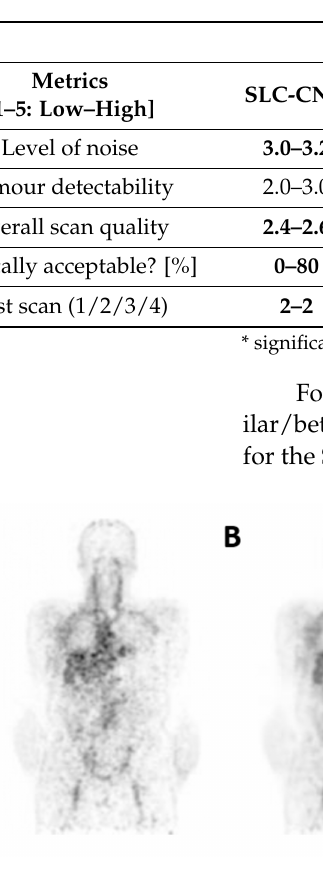
Figure 5. Illustration of a ( A ) FC, ( B ) SLC-CNN, ( C ) BF 3 mm, ( D ) BF 4 mm, ( E ) BF 5 mm denoised